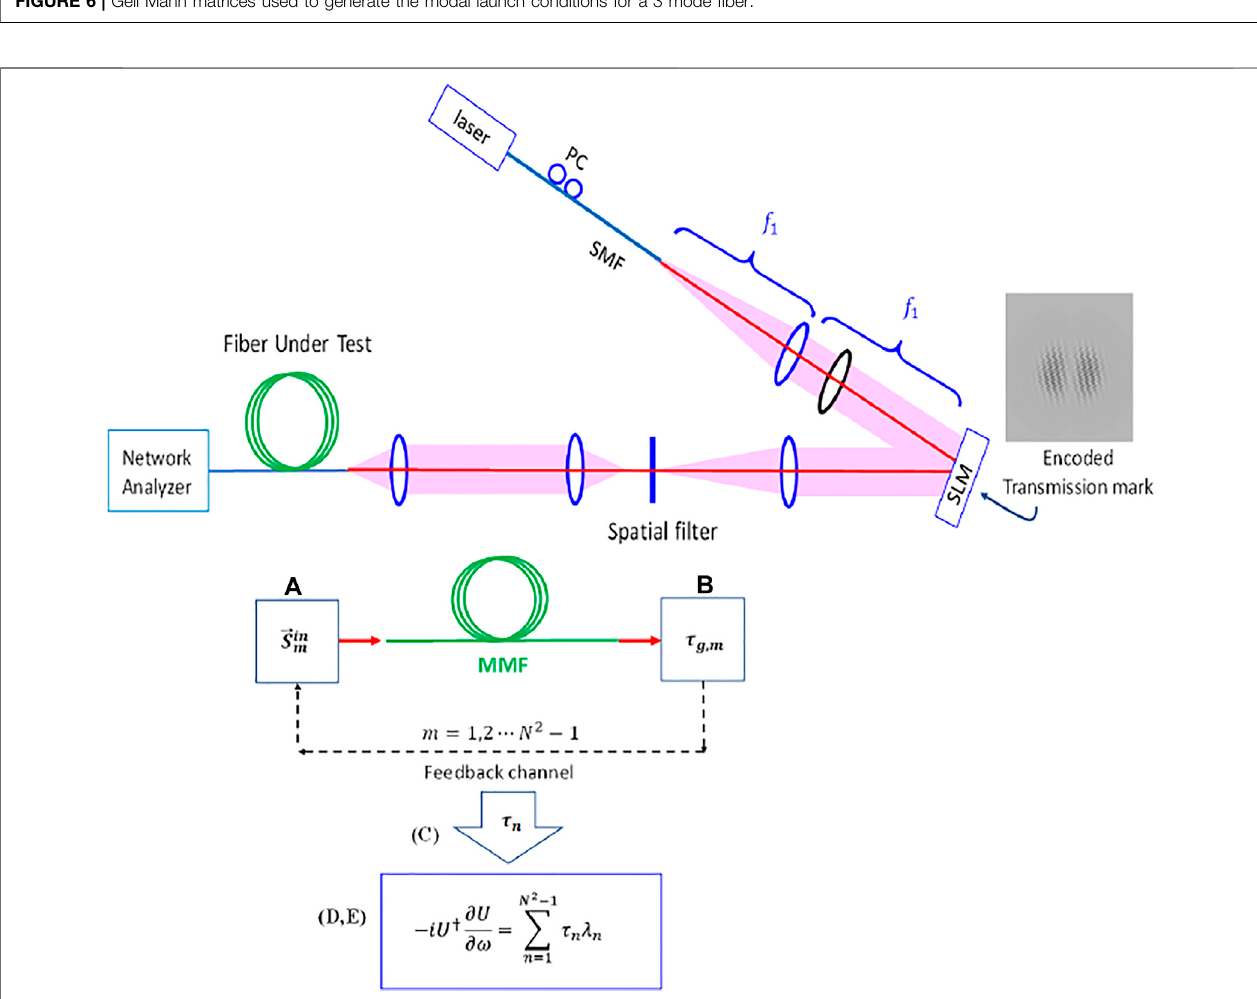
FIGURE7| Experimental arrangementtocharacterizethe3mode fi ber.Pulsesarelaunched,throughaspatiallightmodulator,ontotheguided modesofthe fi ber. Eightseparatelaunchconditions,asspeci fi edbytheGellMannmatrices,arelaunchedtomeasure8differentmeangroupdelays.Thesedelaysaretheninsertedintothe eigenvalue equation to determine the 3 eigenfunctions, principal modes.